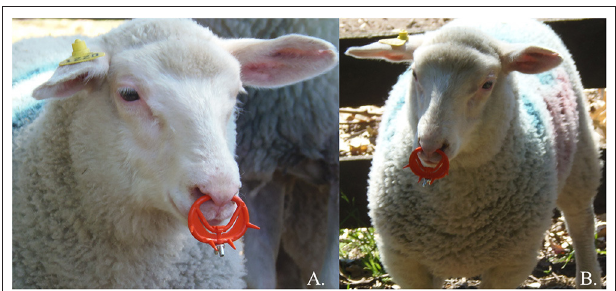
FIGURE 4 | Lamb with a nose-flap (A,B) . Pictures provided by Daniela